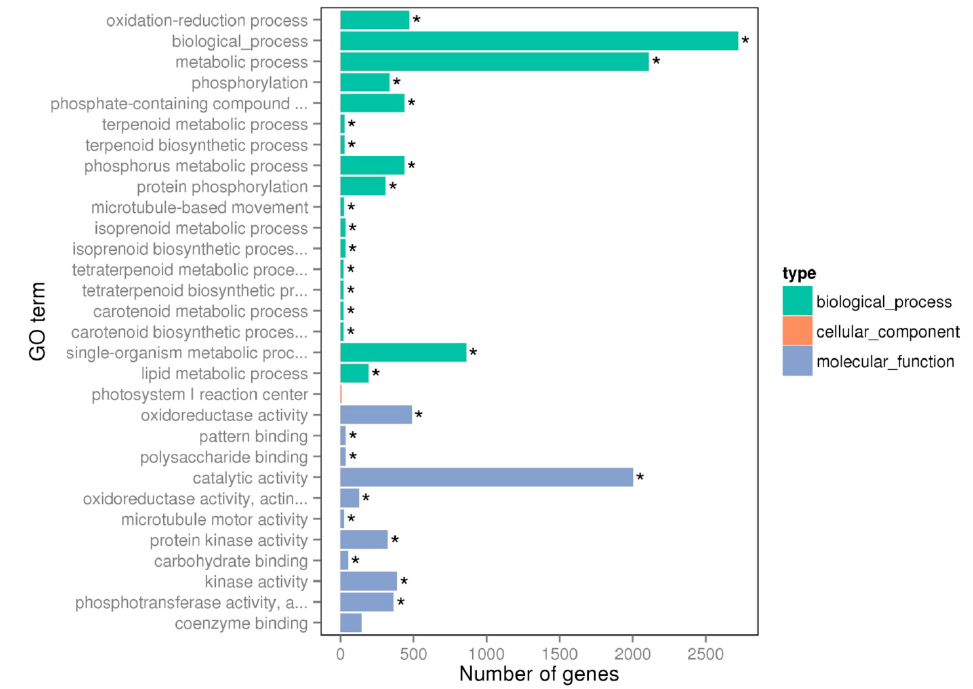
Figure 4. Gene ontology (GO) term enrichment analysis of differentially expressed genes (DEGs) in C. sinensis leaves. * Asterisk means DEGs were significantly enriched in this GO term. Table 1. Basic information of transcriptomic analysis of C. sinensis leaves under different Mg treatments.